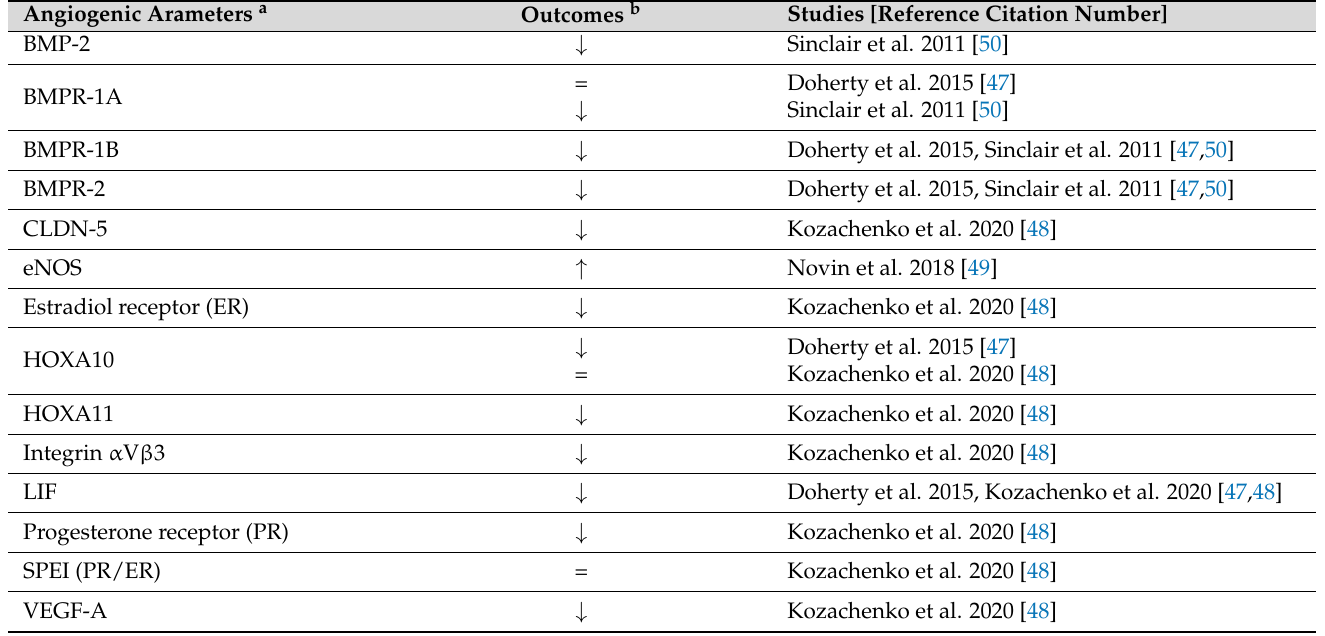
Table 6. Outcomes of the included articles regarding angiogenesis in patients with fibroids and